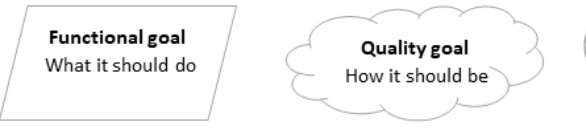
Figure 1. Notation for goal